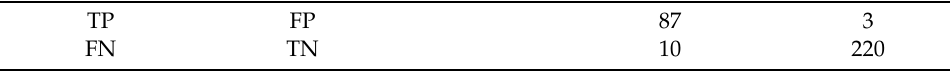
Table 6. Binary confusion matrix for class C1.